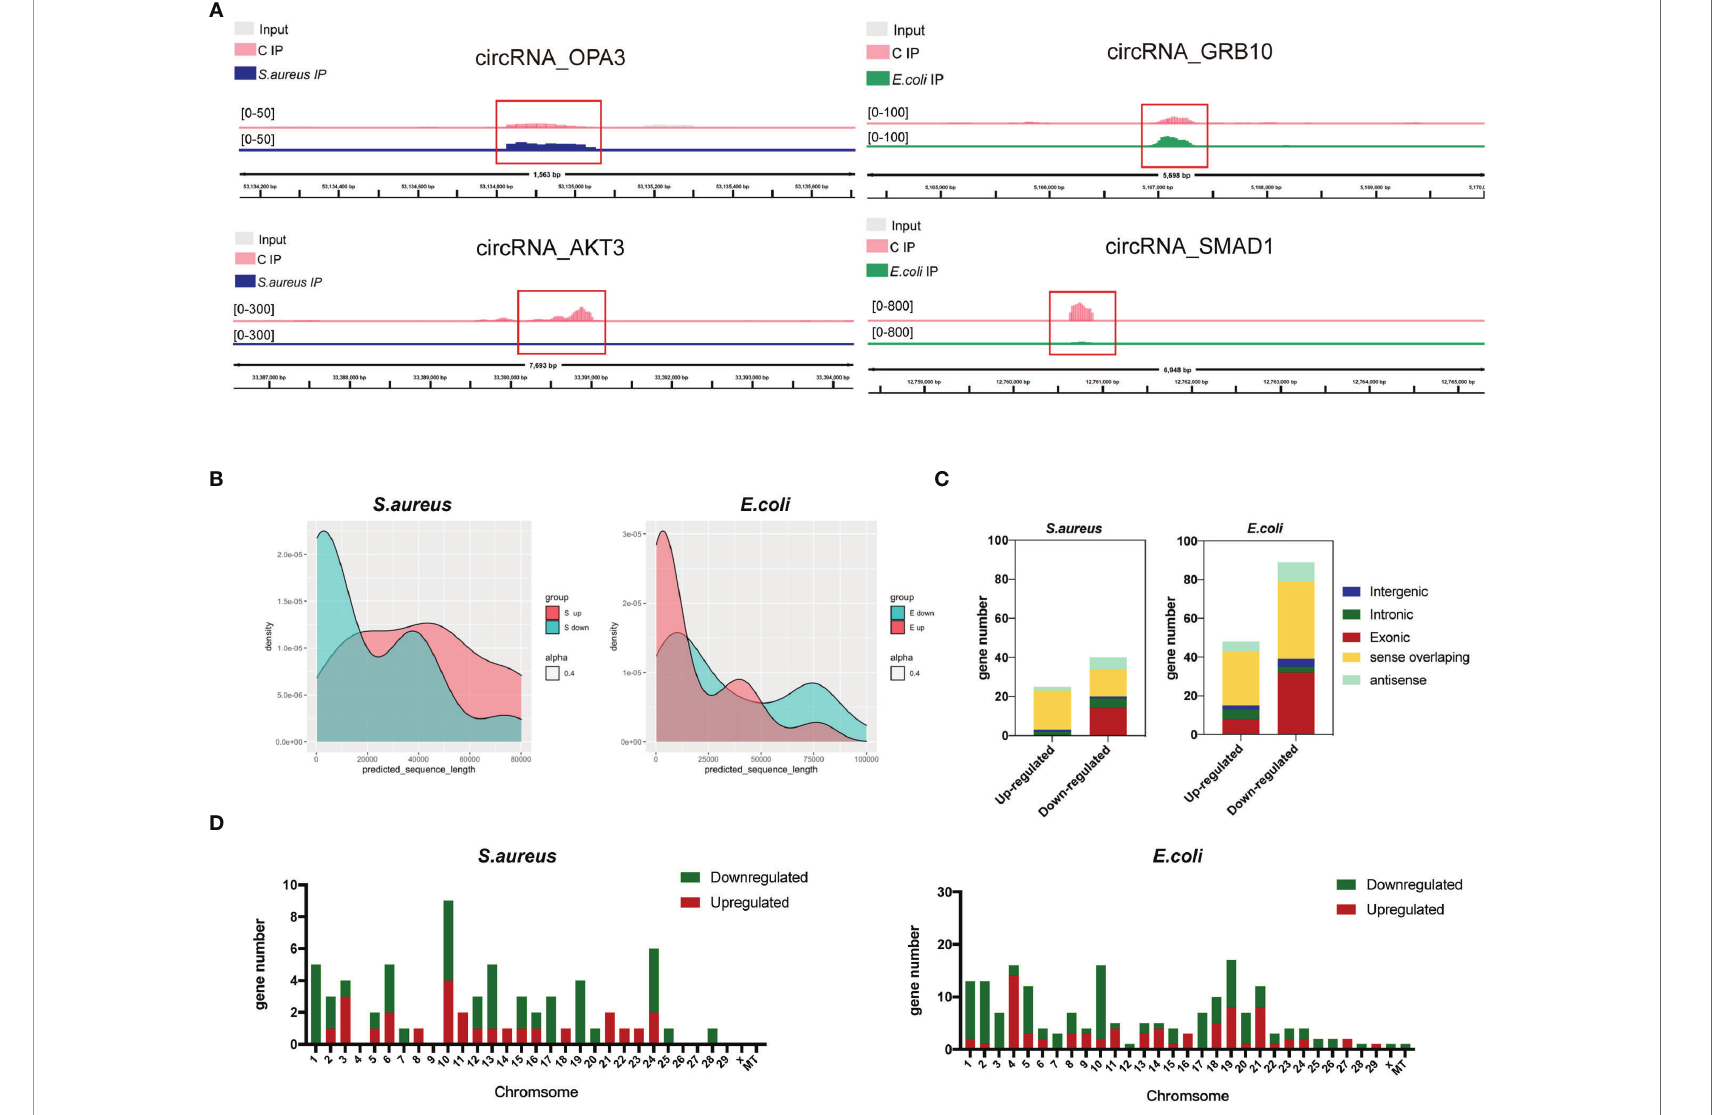
FIGURE 3 | Distribution of signi fi cantly differentially expressed m 6 A-modi fi ed circRNAs in the S. aureus/E. coli group compared to the control group. (A) Data visualization analysis was performed by IGV, showing the location of differential m 6 A peaks in the source gene of circRNA (circRNA_OPA3, circRNA_AKT3, circRNA_GRB10, and circRNA_SMAD1) between the control group and treatment group. (B) The length, (C) source, and (D) chromosome distribution of differentially expressed m 6 A-modi fi ed circRNAs in the S. aureus and E. coli groups (circRNAs were named by their host